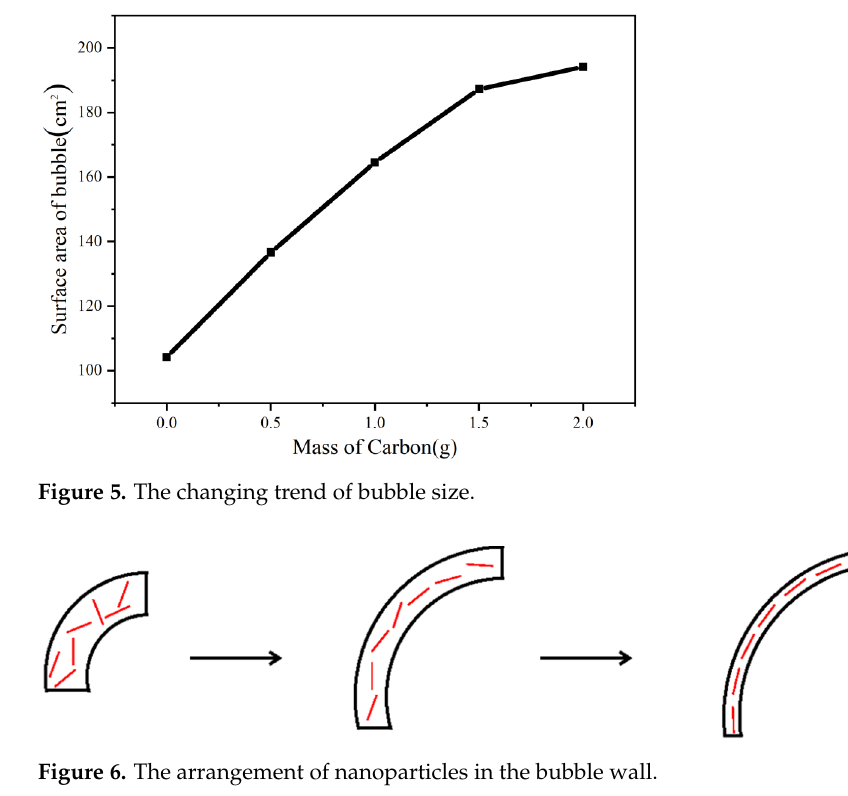
Figure 4. Bubble produced in bubble-electrospinng (Spinning solutions with different amounts of carbon nanoparticles). ( a ) 0 g, ( b ) 0.5 g, ( c ) 1 g, ( d ) 1.5 g, ( e ) 2 g.